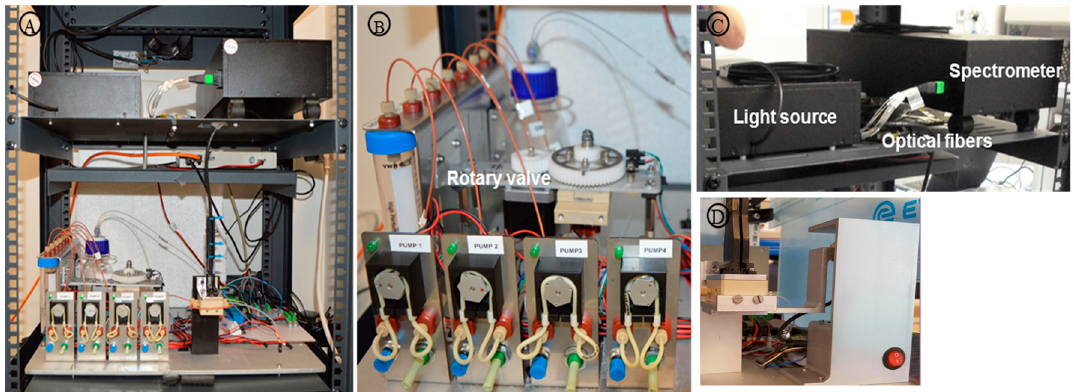
Figure 9. ( A ) Optofluidic sensing system integration. ( B ) Fluidic unit: rotary valve, peristaltic pumps and reservoirs. ( C ) Optical Integration Unit. ( D ) Chip and exchanging mechanism unit.